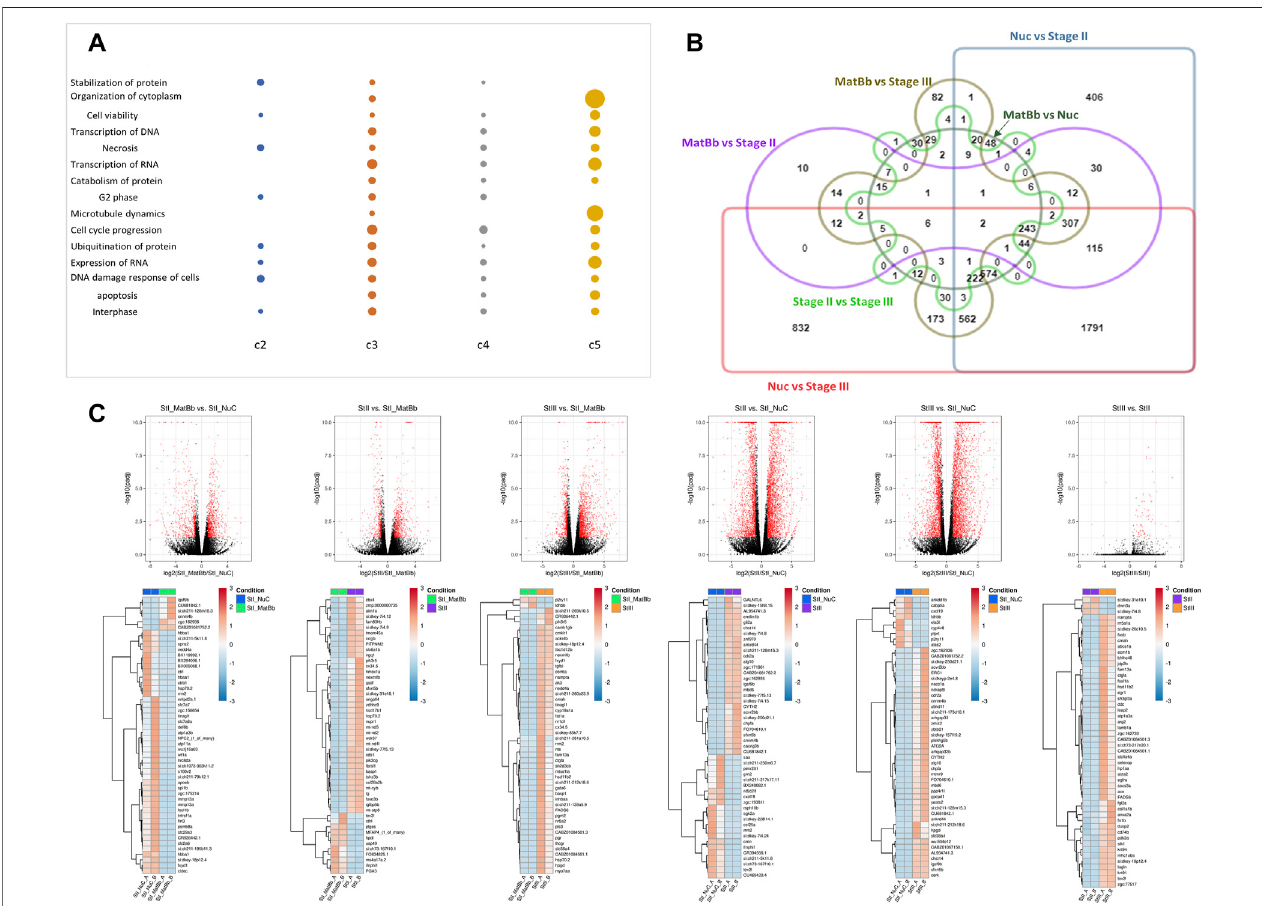
FIGURE 3 | Analysis of differentially expressed genes of different stages. (A) A dot plot of functionally enriched terms that were associated with at least 3 different clusters. The size of the dot is representative of the [ – log( p -value)] corrected for FDR. The larger the dot the smaller the p value. A missing dot means that the speci fi c functionwasnotfoundinthecluster. (B) Edwardsvenndiagramofdifferentialexpressionofgenesbetweenallpairs.TheSymbreakstagewasomittedfromtheanalysis. Each pairwise analysis is denoted by name, color, and shape. Genes were determined as differentially expressed if they had a fold change of at least 2 and FDR < 0.05. (C) Top:VolcanoplotsofpairwiseanalysisofDEGs.Reddotsareforsigni fi cantgenes,blackdotsareforallothergenes(notsigni fi cant).Bottom:Heatmaps for the top 50 signi fi cantly expressed genes according to absolute fold change.